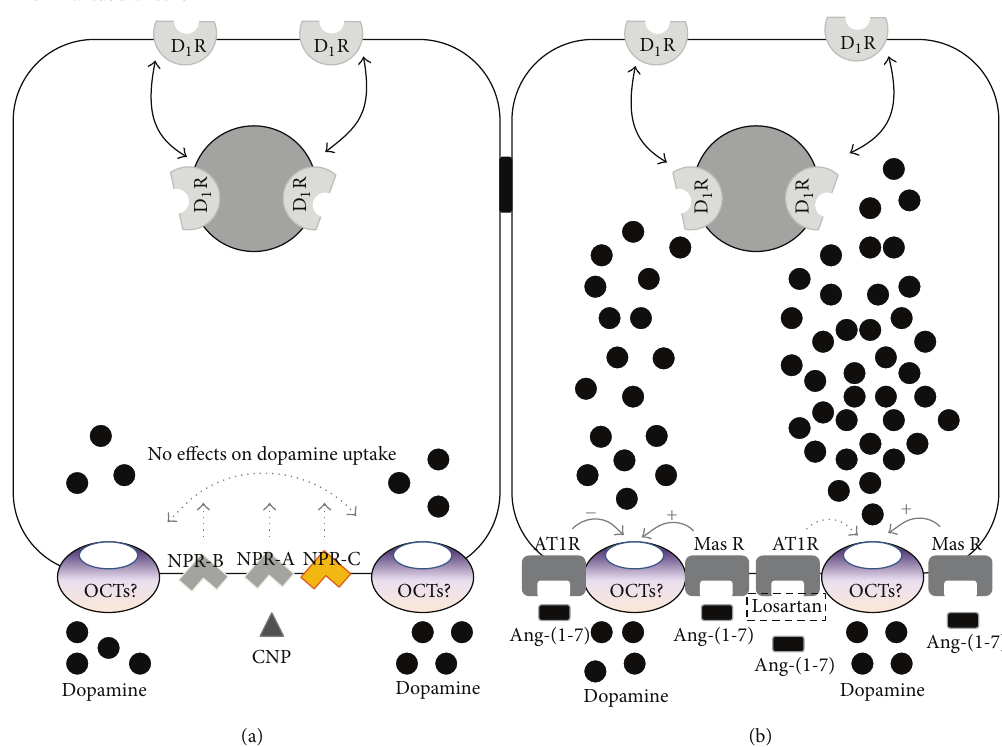
Figure 8: Schematic representation of the mechanism by which CNP and Ang-(1-7) ((a) and (b), resp.) could enhance dopamine tubular transport in proximal tubule cells, by stimulation of extraneuronal uptake. OCTs: organic cationic transporters. Black circles: dopamine; gray triangle: CNP. Black square: Ang-(1-7). Full arrows and +: stimulation; full arrows and − : inhibition; dot arrows: no effect; ?: hypothetical